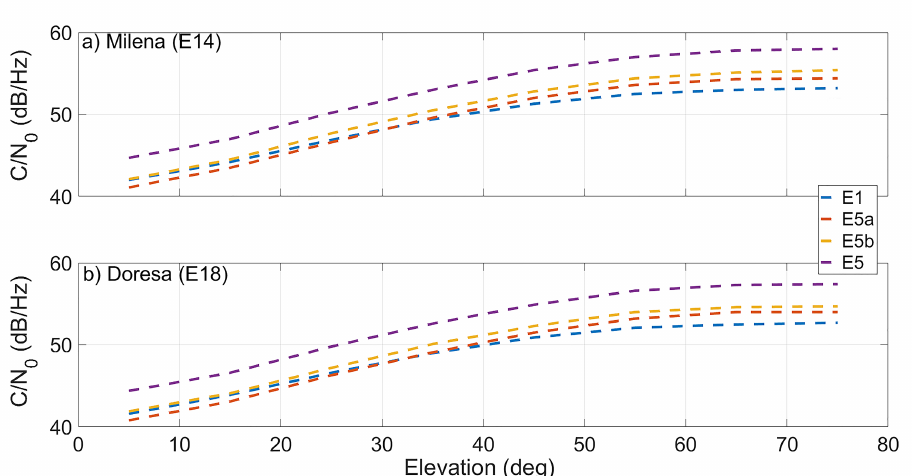
Figure 4. Carrier-to-noise density ratio (C/N 0 ) of the Milena (E14) and Doresa (E18) satellites on different frequencies, E1 (blue), E5a (red), E5b (yellow), and E5 (purple), as a function of satellite elevation plotted in ( a , b ) respectively.